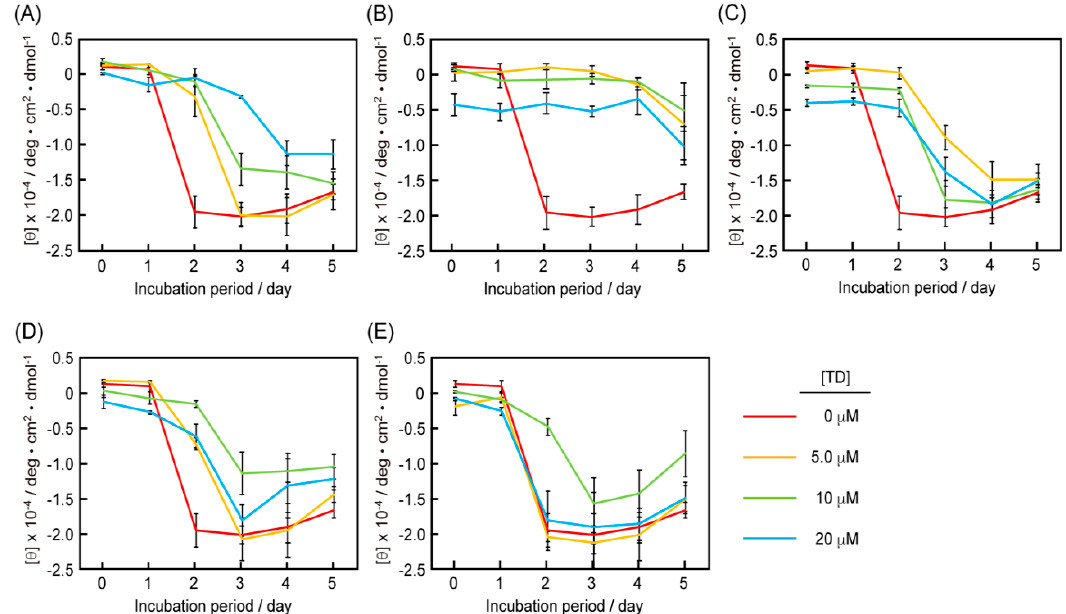
Figure 3. The mean residue ellipticity at 225 nm of the CD spectra of RU003 in the absence and presence of the RU003 tandem-homodimers ( A ) Abu4-TD, ( B ) Ape5-TD, ( C ) Ahx6-TD, ( D ) Ahp7-TD, and ( E ) Aoc8-TD as a function of incubation period (conditions: [RU003] = 100 µM and [TD] = 0, 5.0, 10, and 20 µM in water at 40 °C, mean ± SD, n = 3). These data were derived from Figures S1–S5.